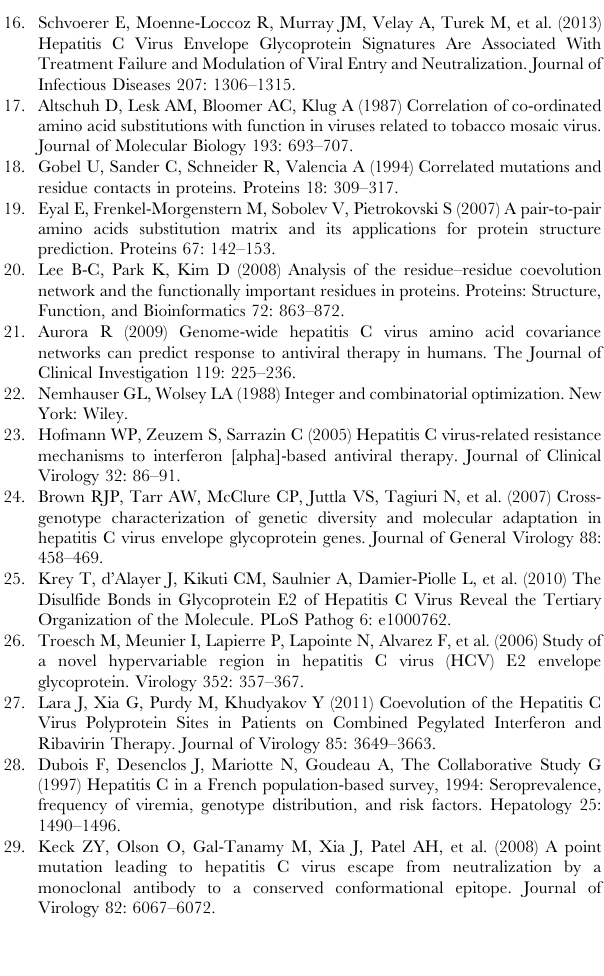
Table S1 Covarying pairs in optimal